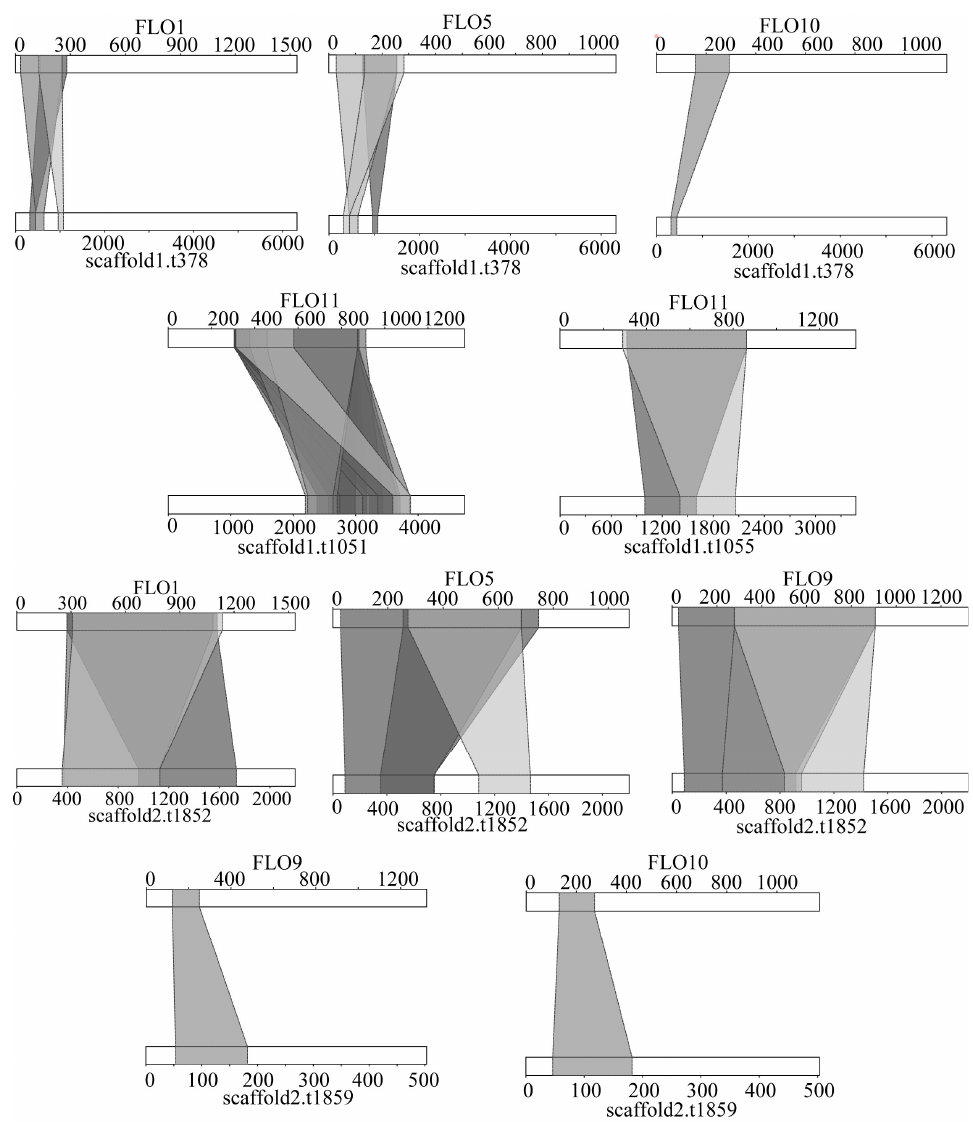
Figure 7. BLAST analysis S. bacillaris CC-PT4 genome against the flocculation protein sequence.